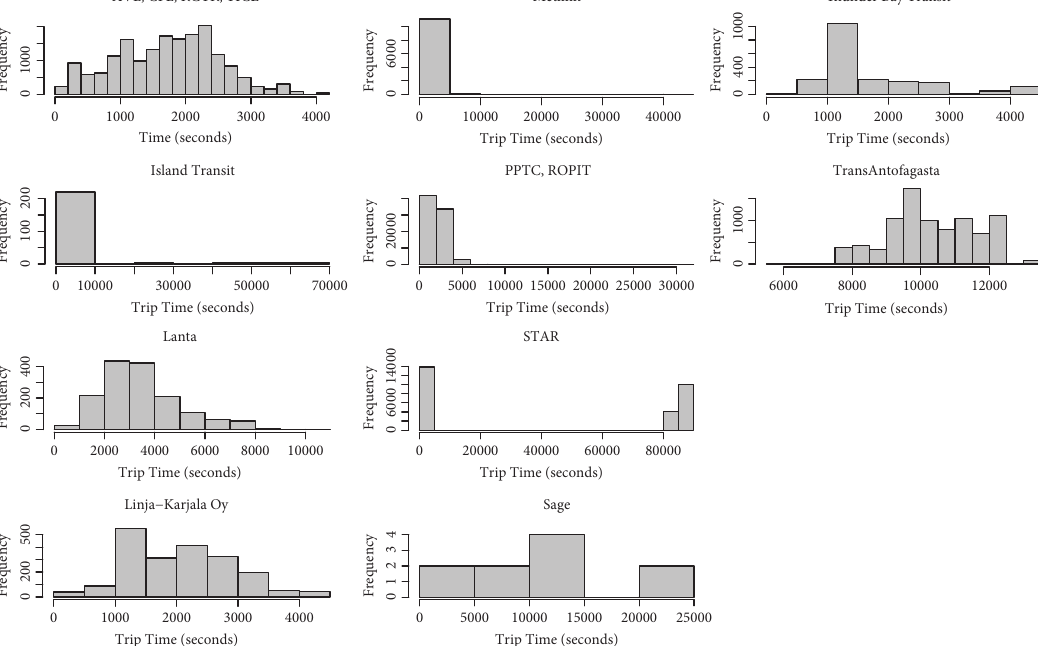
Figure 1: Histogram of trip time.